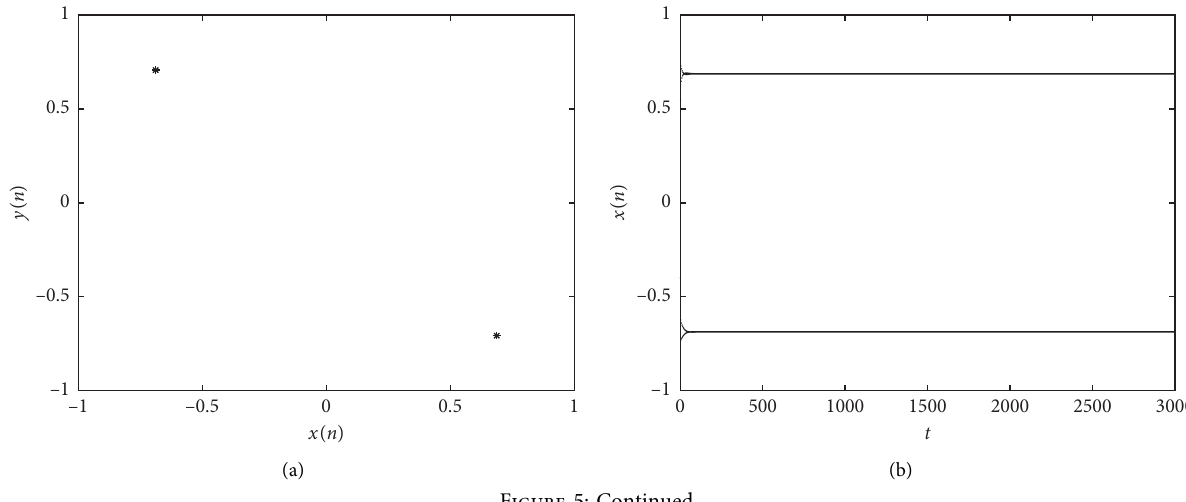
, (c) the LLE spectrum with x , and (d) the LLE spectrum with x 02 01